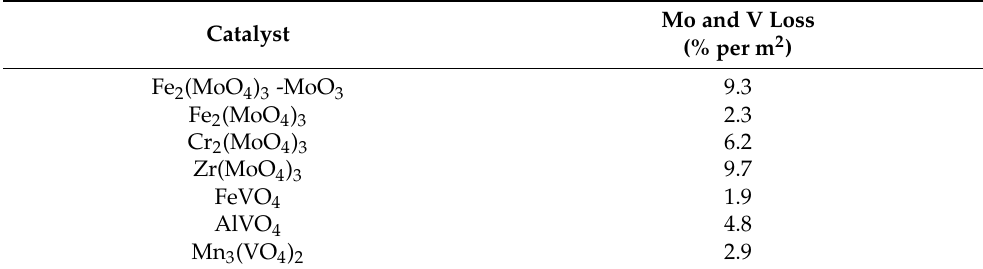
Table 6. Volatilization of vanadium and molybdenum from a selection of vanadates and molybdates, respectively. Reprint from [99]. Copyright (2021), with permission from Springer Nature.